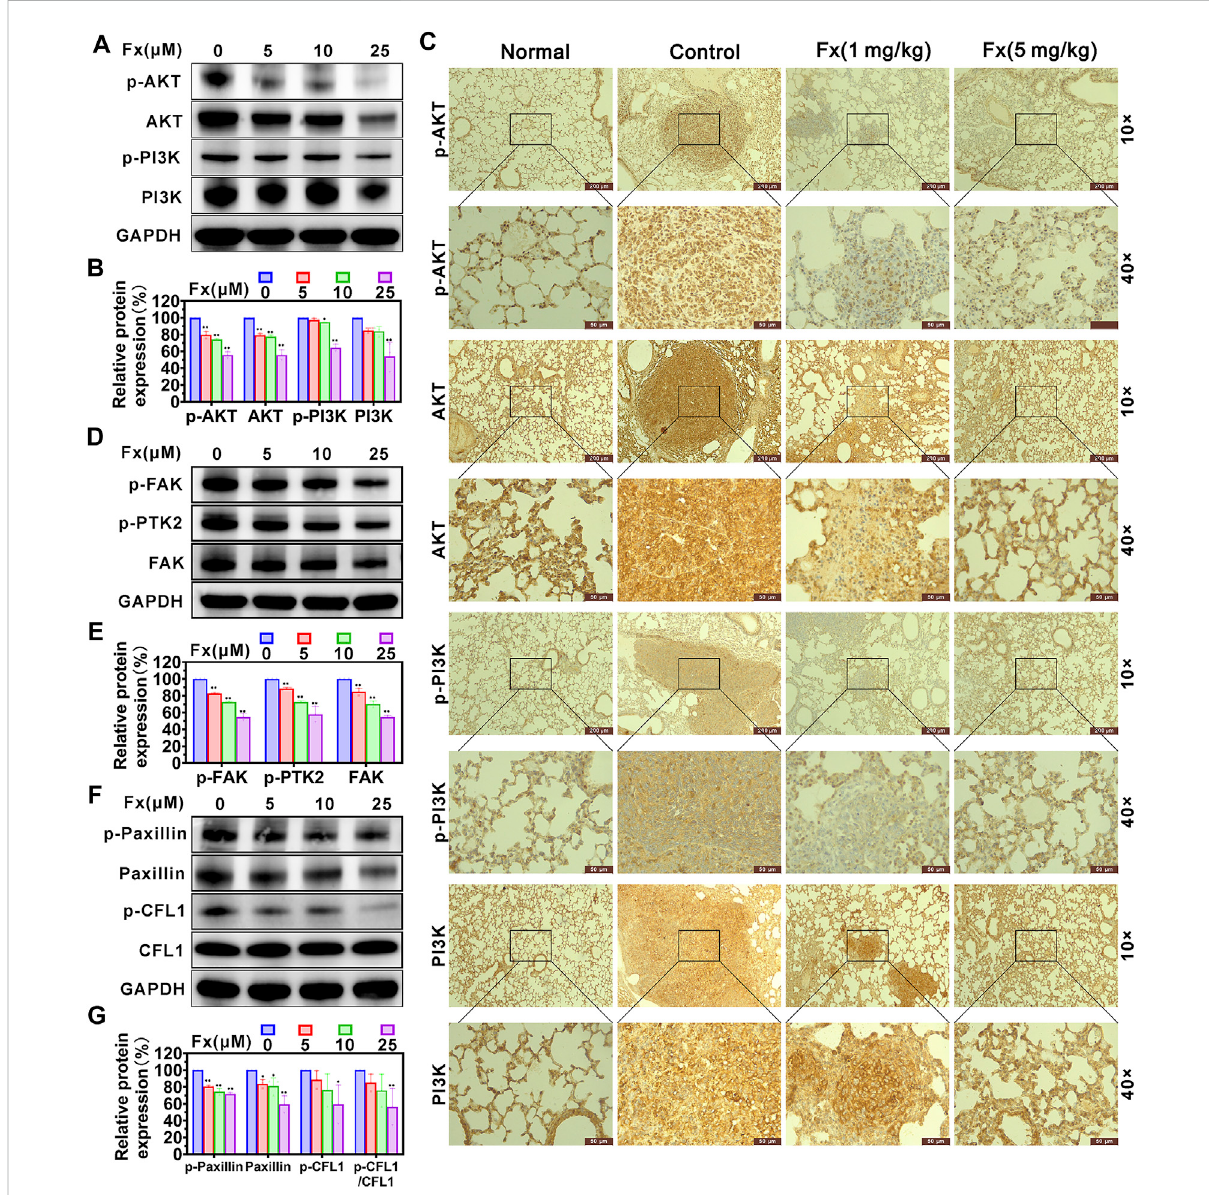
FIGURE 6 Fx inhibits PI3K/AKT and FAK/Paxillin signaling pathways in MCF-7 cells and lung metastases. MCF-7 cells were treated with Fx for 24 h, and the expression levels ofAKT1/2/3, p-AKT1/2/3 (AKT1-Tyr 315/AKT2-Tyr316/AKT3-Tyr312), PI3K, p-PI3K (Tyr458),FAK, p-FAK (Tyr 397),p-PTK2 (Tyr 576/ 577), Paxillin, p-Paxillin (Tyr 118), CFL1 and p-CFL1 (Ser 3) were analyzed by western blot, GAPDH was used as an internal control. Band intensity was quanti fi ed using Image Lab software and expressed as a percentage of control (Fx free). (A , B) Fx signi fi cantly inhibited the total and phosphorylation levels of PI3K and AKT proteins in MCF-7 cells in dose-dependent manners. (C) BALB/c mice were pre-treated with Fx for 3 days (0 mg/kg, 1 mg/kg, 5 mg/kg, the volume of Fx is 100 μ l per mouse, i.p., q.d.) prior to inoculation with 4T1 cells (5 × 104 cells/mouse, tail vein injection), followed by continued treatment for 21 days. Representative immunohistochemical staining for AKT1/2/3, p-AKT1/2/3 (AKT1-Tyr 315/ AKT2-Tyr316/AKT3-Tyr312),PI3K,p-PI3K(Tyr458)inlungmetastasesareshown. (D – G) Fxsigni fi